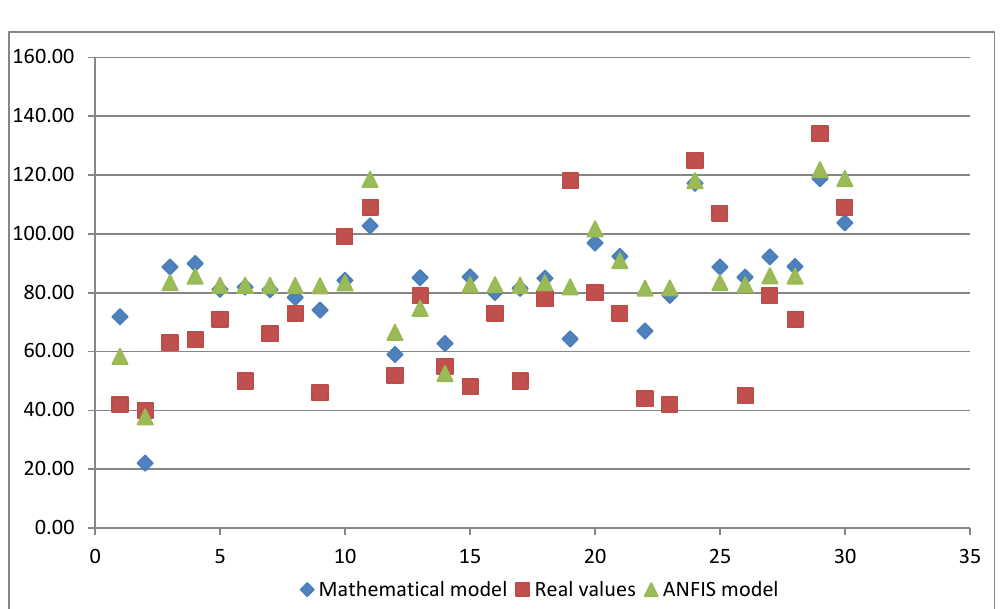
Figure 12. Values obtained by the mathematical and ANFIS model and the actual measured ones.